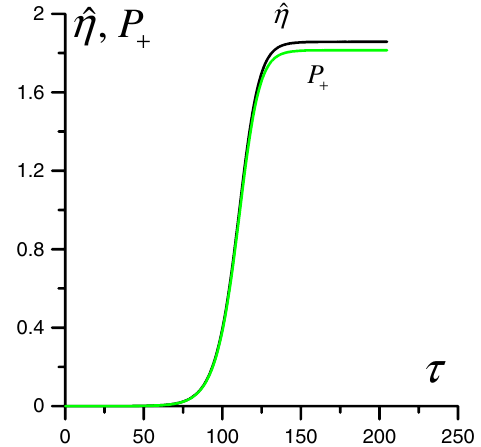
FIG. 4. (Color) Temporal dependence of efficiency (black line) and normalized output power (green line) at L 1 ¼ 1 , L 0 ¼ 2 , L 2 ¼ 0 : 5 , ^ (cid:2) 1 ¼ 1 : 1 , ^ (cid:2) 2 ¼ 0 : 8 , (cid:4) ¼ (cid:3) 1 , and ^ (cid:3) ¼ 0 : 1